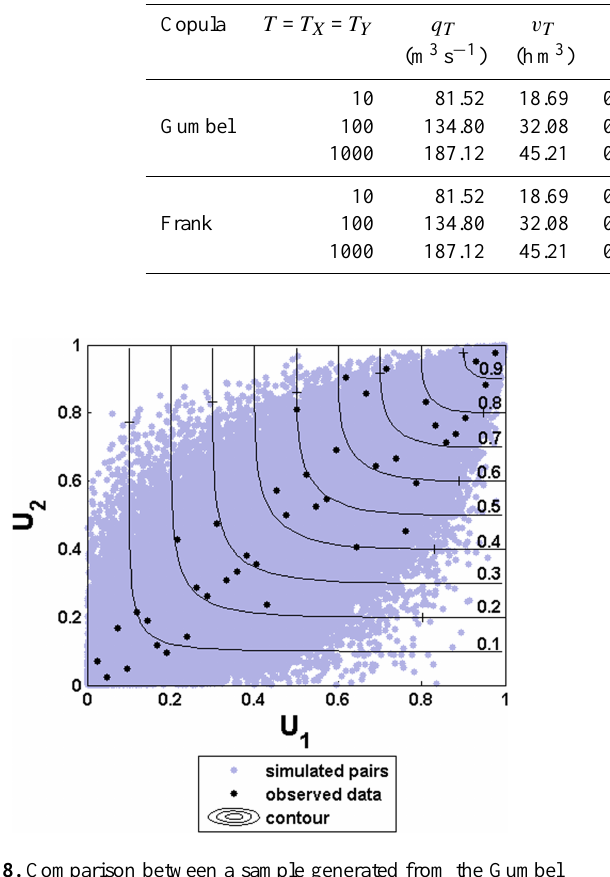
Fig. 8. Comparison between a sample generated from the Gumbel copula and the observed data with the copula contours.